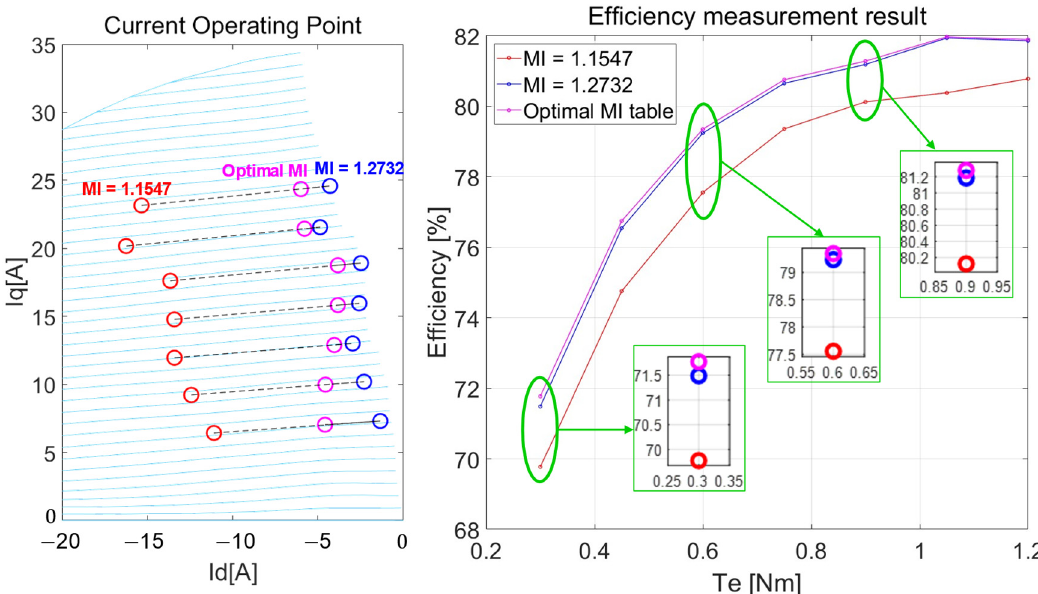
Figure 19. Efficiency comparison of fixed MI control and optimal MI control.